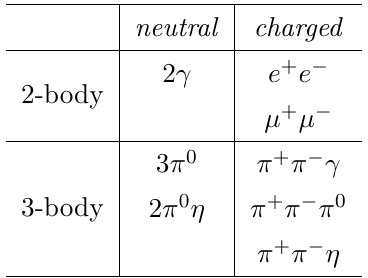
Table 1 . Allowed decay channels for ALPs with masses up to about 1 GeV